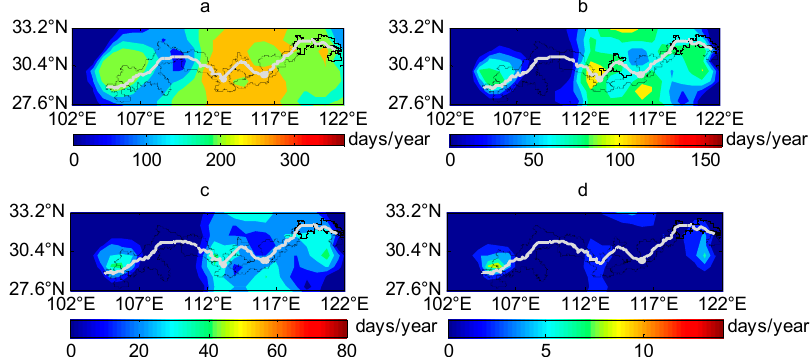
Figure 4. Number of days with the heat wave (( a ) slight risk, ( b ) middle risk, ( c ) high risk and ( d ) extreme risk) during the period 1979–2017 based on ERA-Interim Reanalysis data.